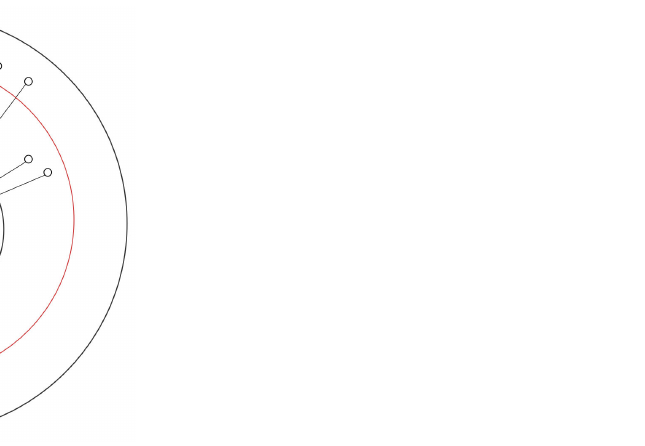
Figure 3. Region segmentation method. The LiDAR is located in the center of all regions, each ring has an equal area, and a ring represents a laser points region. There are three regions in the figure.